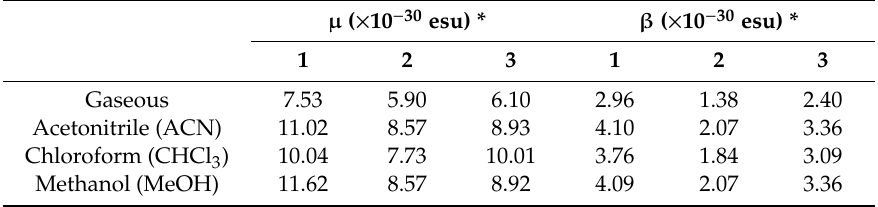
Table 8. Comparison of dipole moment ( µ tot ) and static hyperpolarizability ( β tot ) in three